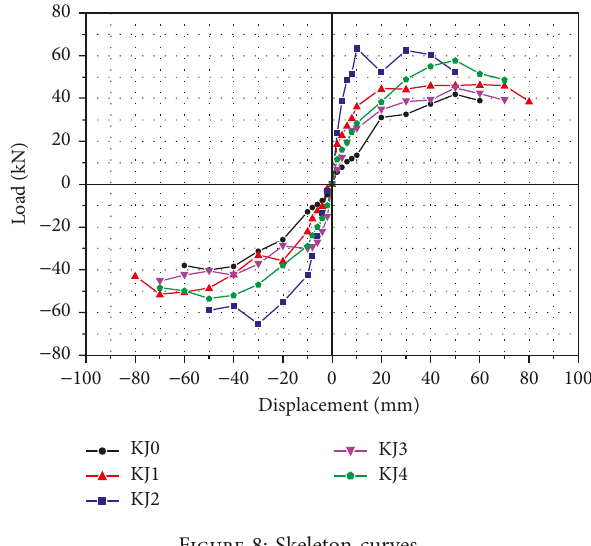
Figure 8: Skeleton